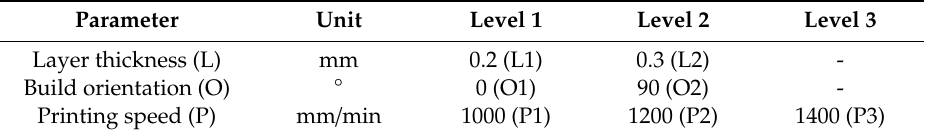
Table 4. Input parameters for the DOE.